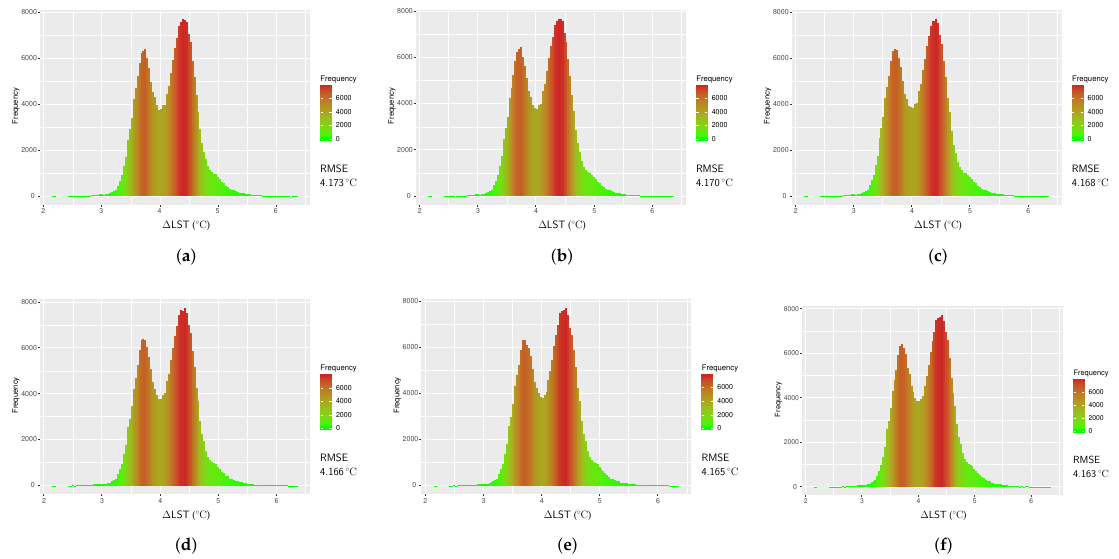
Figure 5. Histograms of temperature difference between the reference LST (LST ref ) and LST from Single-Channel algorithm (LST SC ) for Landsat 8 image of 21 February 2018; ( a ) w = 0.5gcm − 2 , ( b ) w = 1.0gcm − 2 , ( c ) w = 1.5gcm − 2 , ( d ) w = 2.0gcm − 2 , ( e ) w = 2.5gcm − 2 , and ( f ) w = 3.0gcm − 2 .